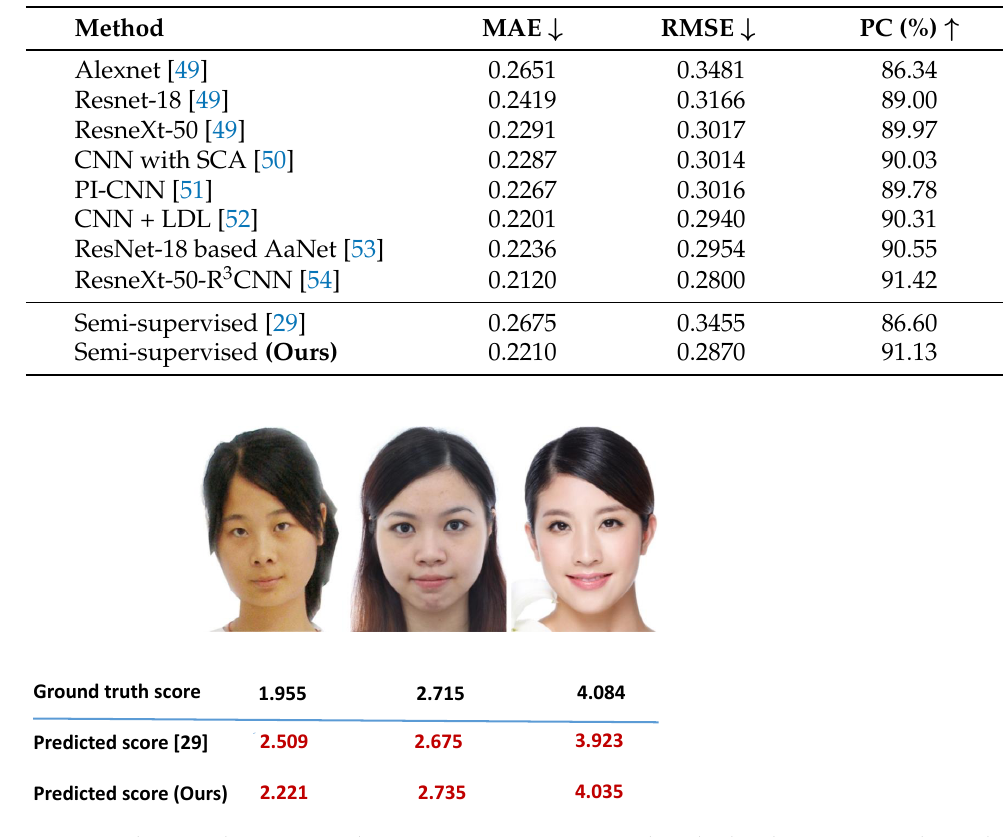
Figure 5. Three prediction examples using two semi-supervised methods. The upper row shows the ground truth